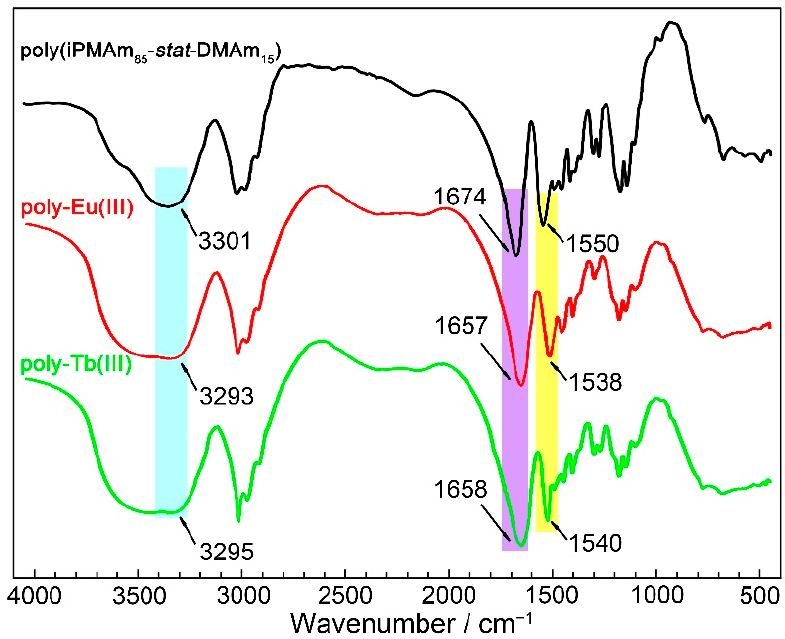
Figure 3. FT-IR spectra of poly(iPMAm 85 - stat -PDMAm 15 ), poly-Eu(III) and poly-Tb(III).